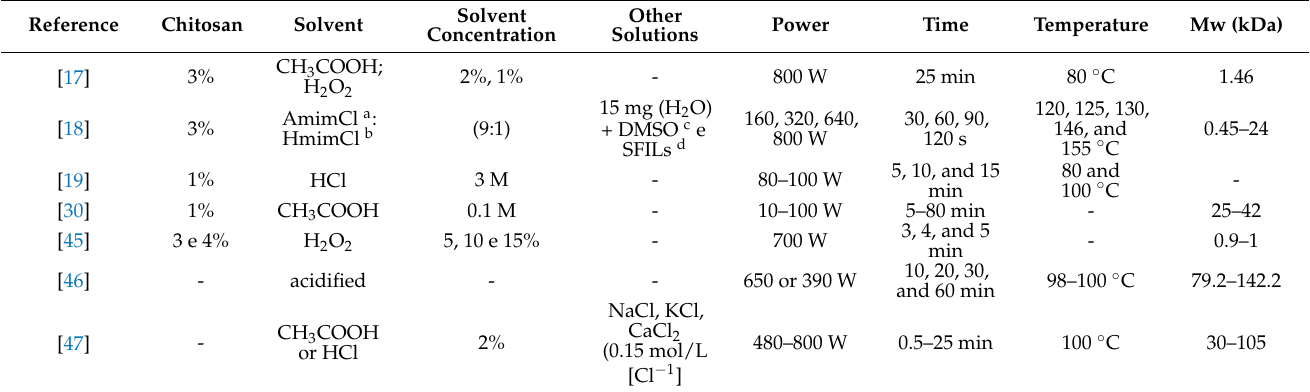
Table 3. Parameters of chitosan hydrolysis by